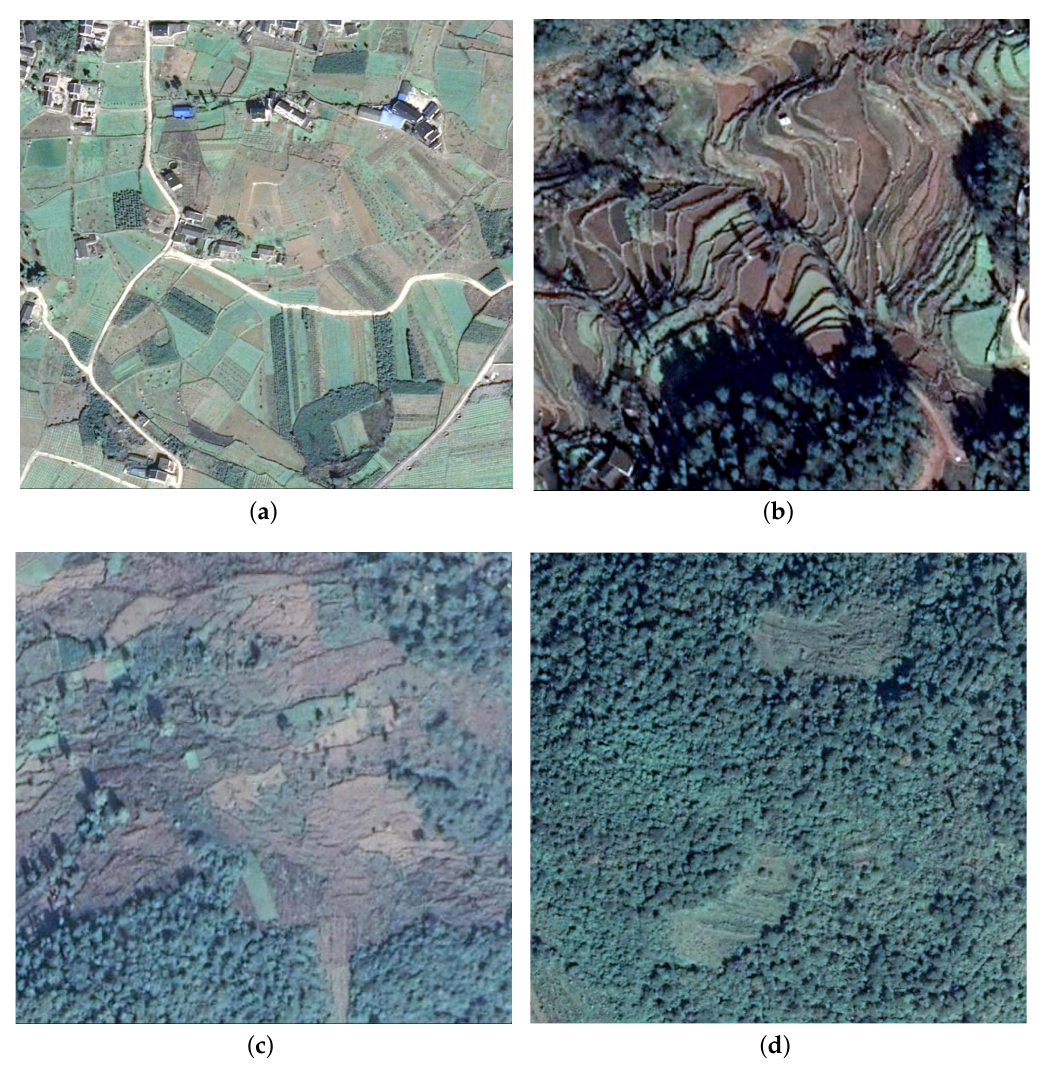
Figure 3. The four farmland types presented in Google Earth imagery: ( a ) regular farmland; ( b ) terraced farmland; ( c ) slope farmland; ( d ) woodland